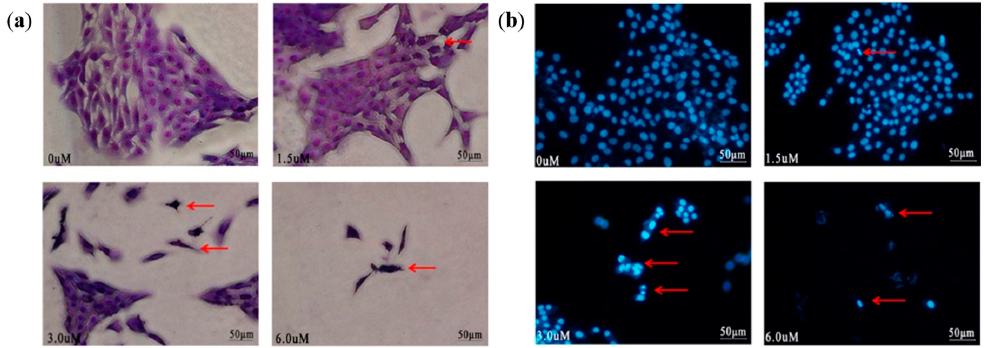
Figure 3. Analysis of HSCs apoptosis using annexinV-FITC/PI staining. Values are expressed as the mean ± SD in each group ( n = 3). * p < 0.01, ** p <0.001 vs. 0 µM.